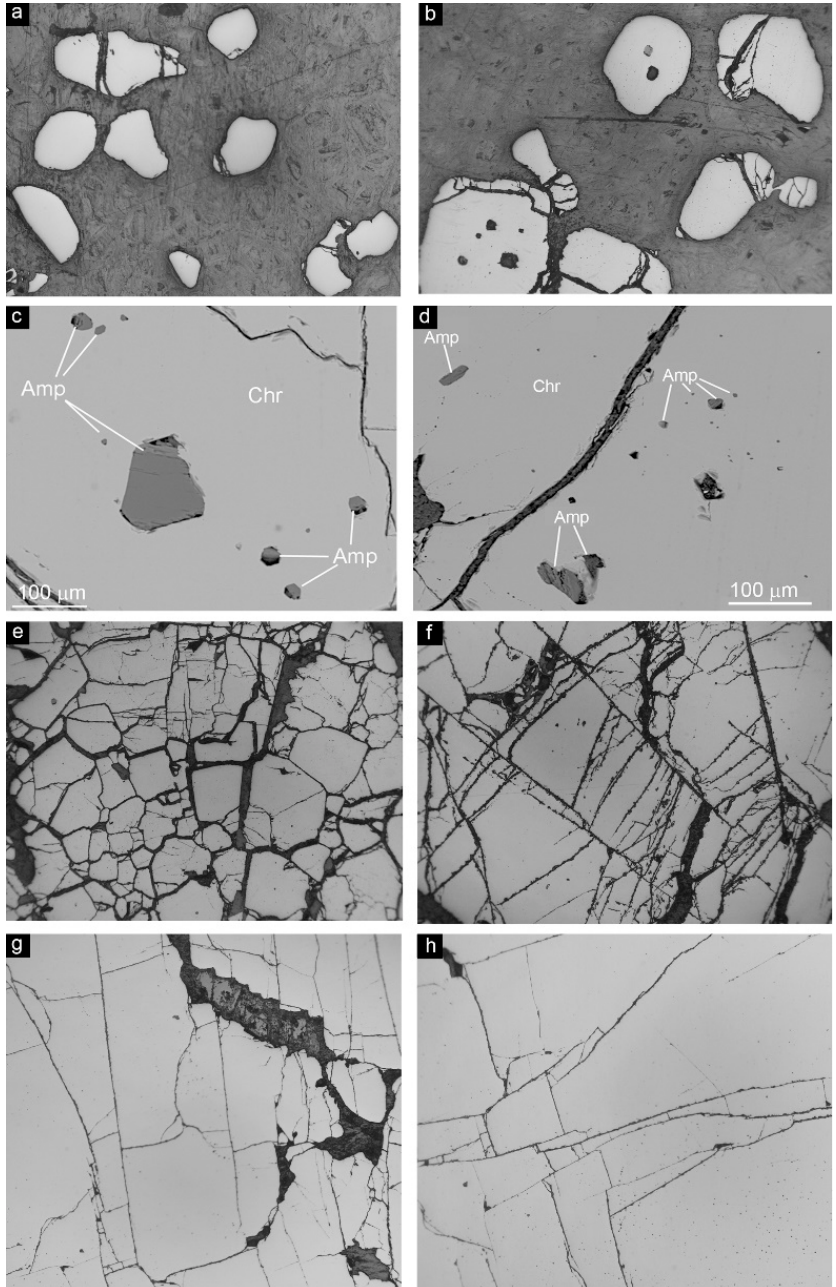
Figure 5. Evolution of chromitite structure in deposits of Kempirsay ophiolite massif: ( a )—Sparsely disseminated fine-grained chromitite consisting of small smooth chromite grains (sample 079/90.7); ( b )—Moderately disseminated chromitite: grains containing pargasite and olivine inclusions